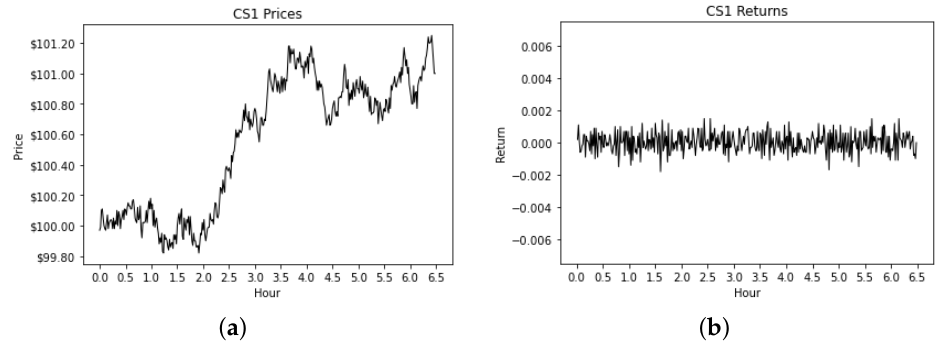
Figure 4. 1-min time series for the FBA (1.0) experiment. ( a ) Price Path. ( b )